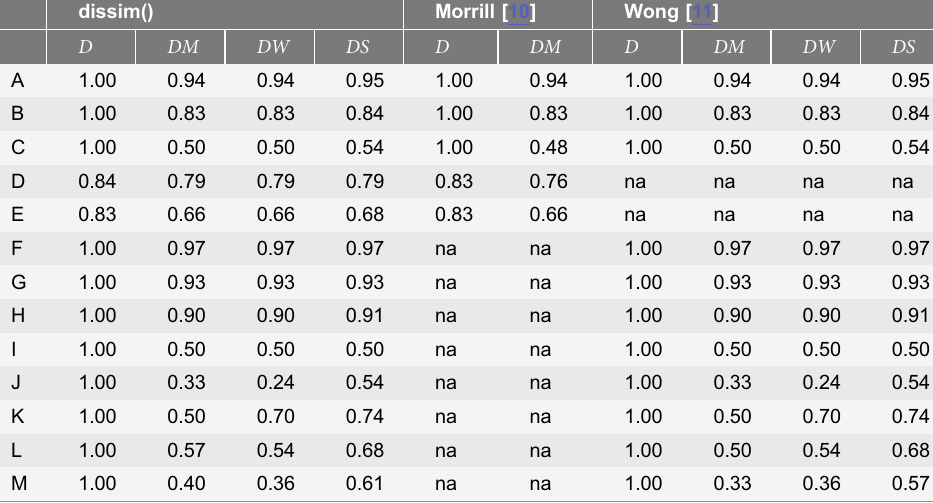
Table 4. D , DM , DW and DS for the hypothetical segregation patterns listed in Table 3. dissim() Morrill [10] Wong